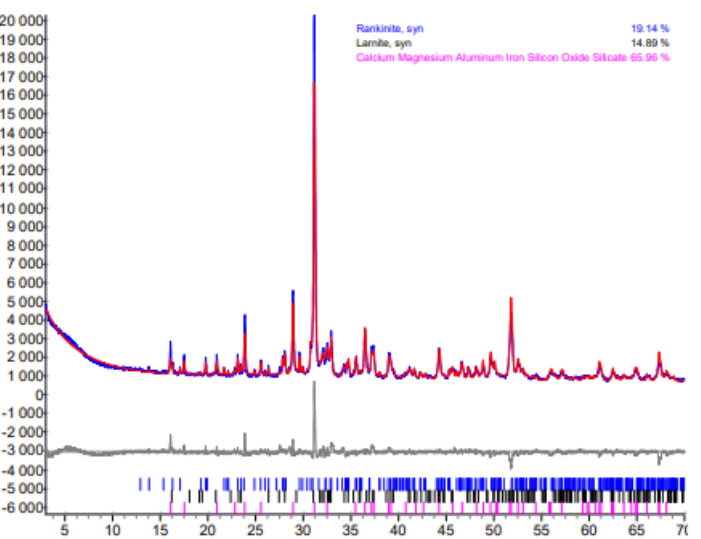
Figure 9. Rietveld analysis curve of the product synthesized at 1150 °C in 45 min from a mixture of Karpenai limestone and Saltiskiai clay with CaO/SiO 2 = 1.5.